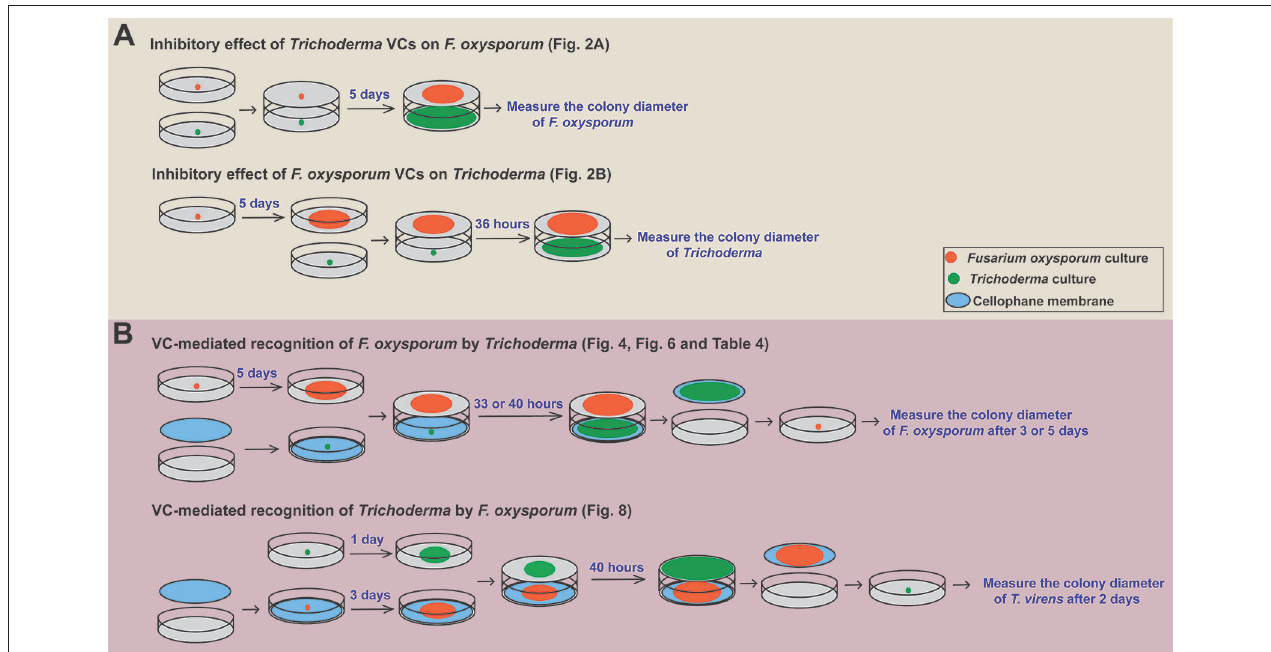
FIGURE 1 | Overview of the experimental setups employed. A schematic representation of how we determined (A) the inhibitory effect of Trichoderma VCs on the growth of F. oxysporum and vice versa and (B) if Trichoderma and F. oxysporum sense VCs from the other side to prepare for subsequent attack is shown. The duration of VC exposure varied significantly among the experiments because Trichoderma grew much faster than F. oxysporum . Specific figures and table generated using each method are